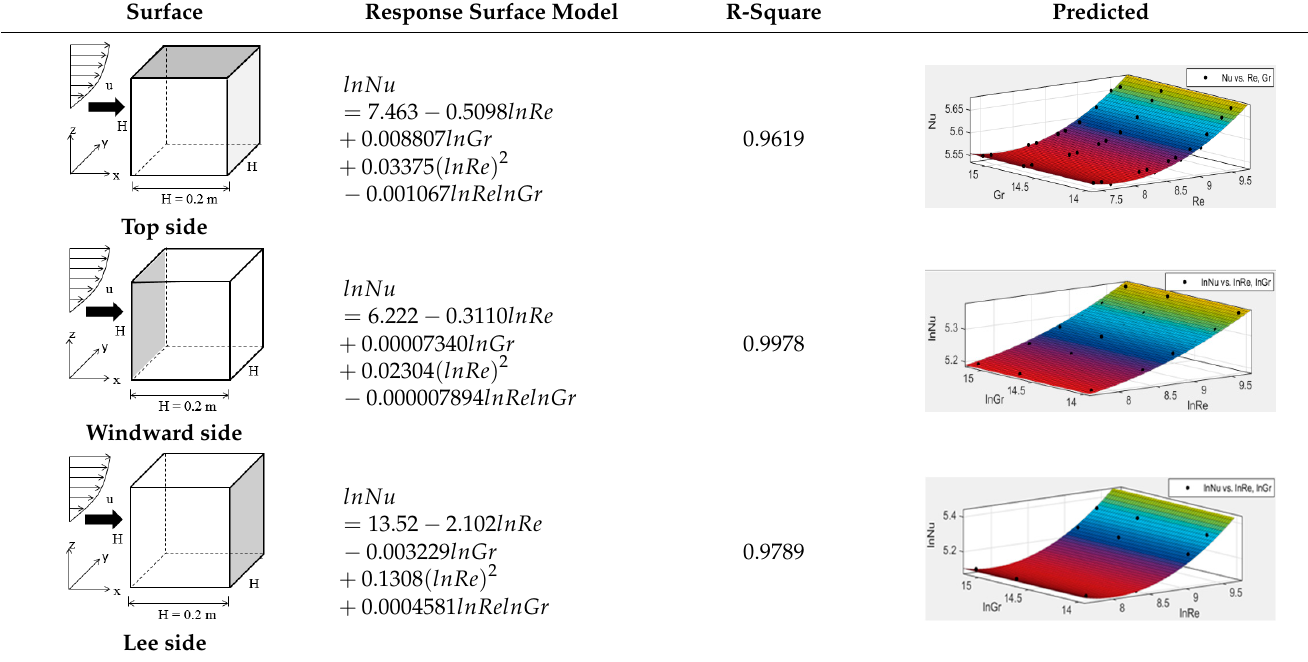
Table 5. RSM fitting formulas under the 30° and 45° wind direction condition.